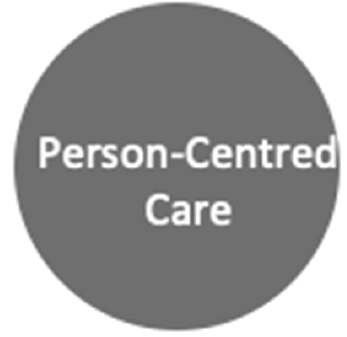
Figure 1. Core of COMPASS person-centred care.